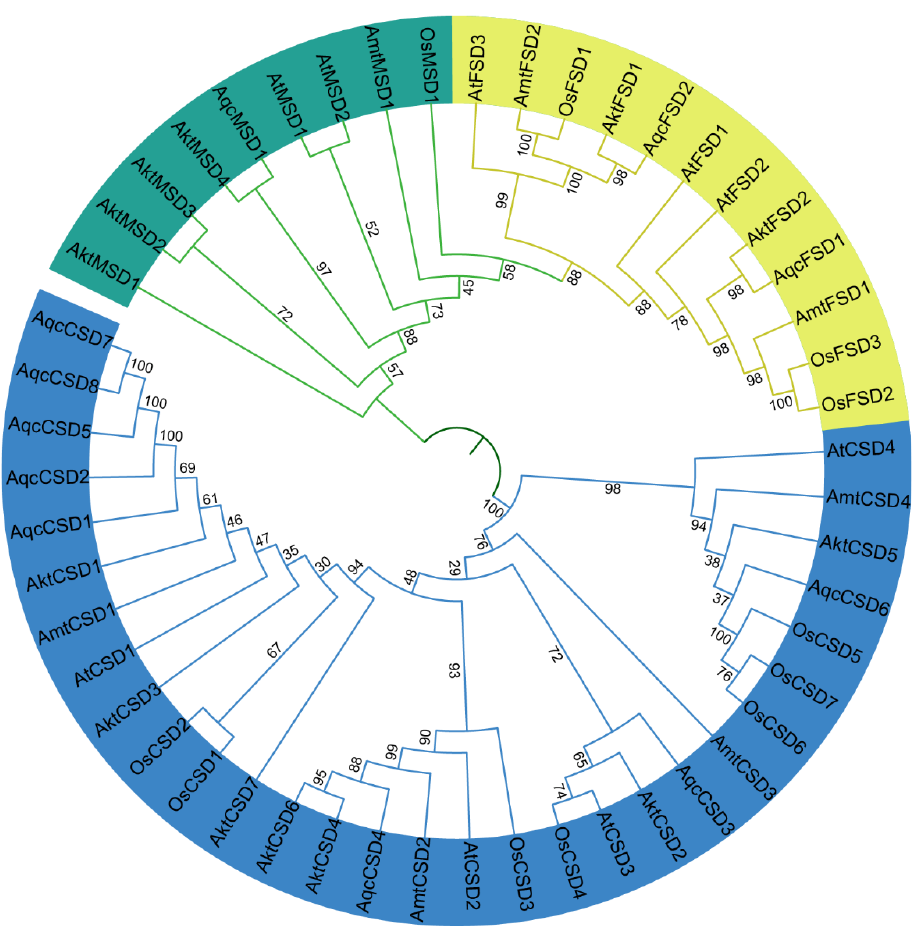
Figure 1. Phylogenetic tree of SOD genes from 4 plants: A. trichopoda , A. coerulea , A. thaliana and O. sativa (the numbers at nodes indicates bootstrap numbers per 1000 replicates determined by maximum likelihood methods).